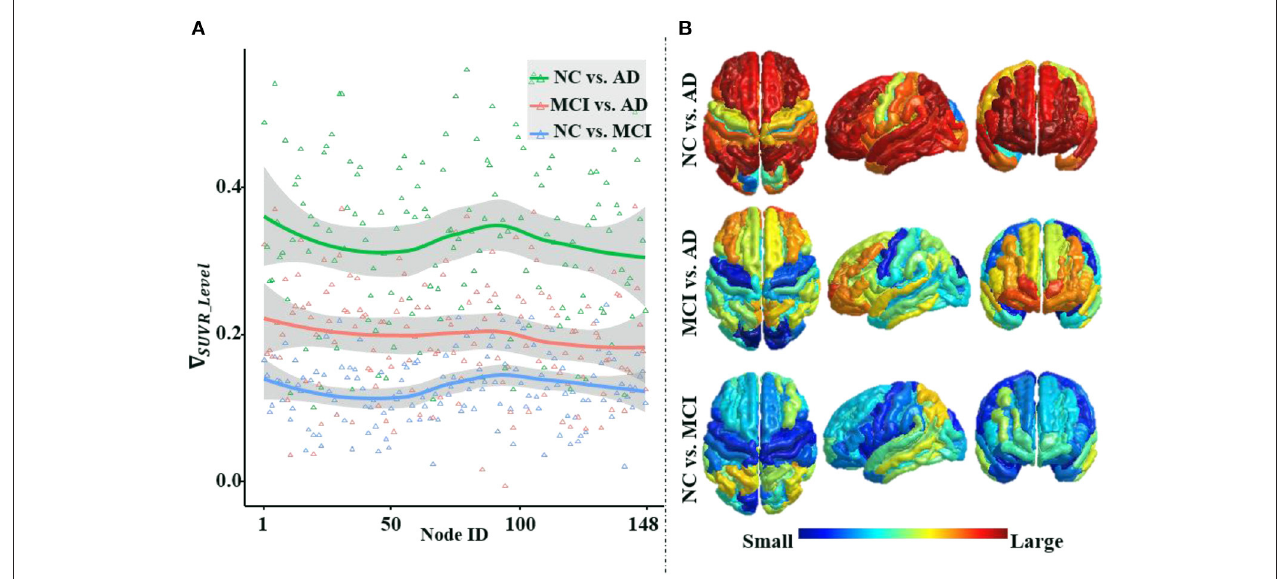
FIGURE 6 | An illustration of the differences in the average regional amyloid level between cohorts. The three curves from top to bottom in panle (A) , respectively, depict the differences in the average amyloid level of each brain region between cohorts NC vs. AD, MCI vs. AD, and NC vs. MCI. Corresponding to panel (A) , from top to bottom, panel (B) depicts the brain region maps of the average amyloid level differences between the cohorts. Node IDs (1–74) correspond to the 74 brain regions in the left hemisphere, node IDs (75–148) to the 74 brain regions in the right hemisphere, and within each hemisphere, the brain regions are numbered based on Destrieux atlas parcellation. MCI, mild cognitive impairment; NC, normal